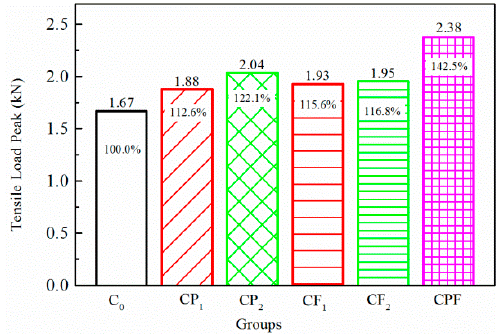
Figure 14. Initial tensile load for 0.2 mm crack opening.